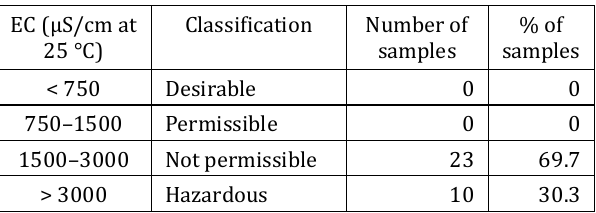
Table 2. Classification of groundwater for drinking based on